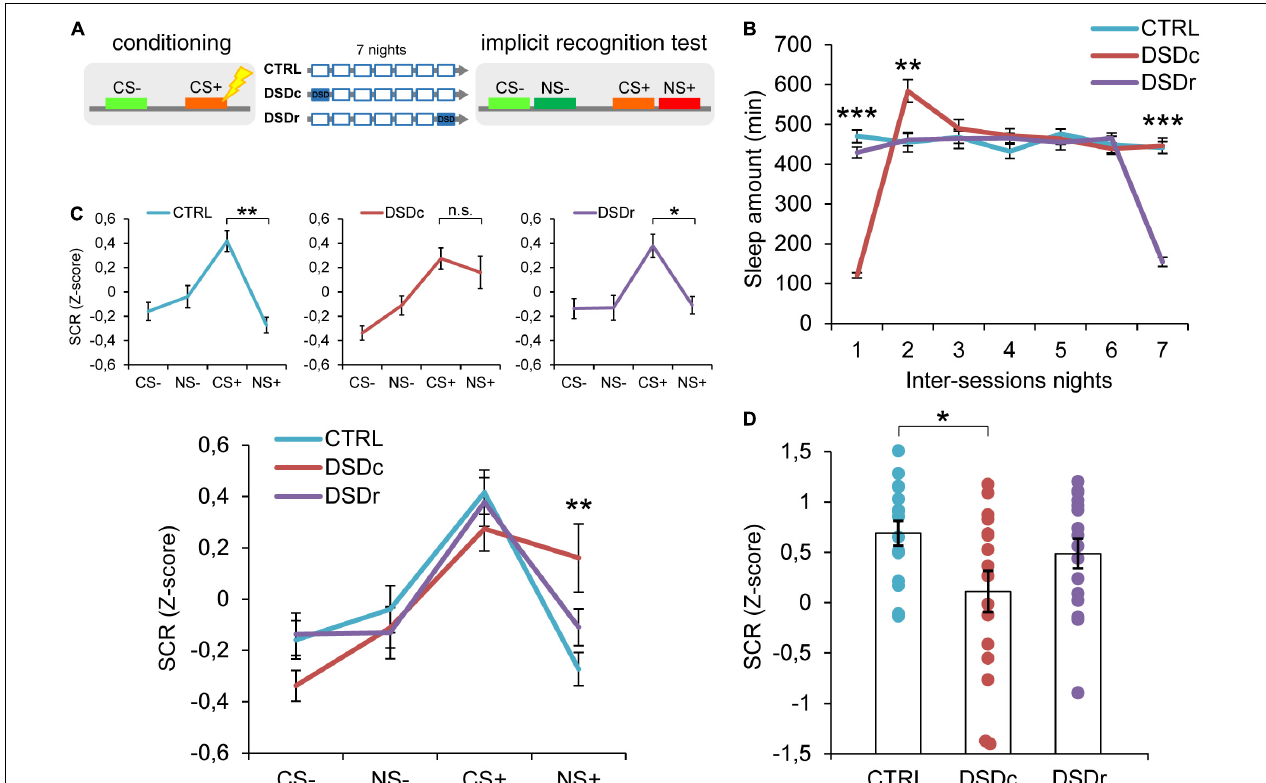
FIGURE 1 | Effects of DSD on implicit threat memories, safety memories, and threat generalization to new stimuli. (A) Schematic diagram depicting the experimental design. Participants underwent a differential threat conditioning in which a conditioned tone (CS+) was paired with a mild electrical shock (US) and a non-reinforced tone (CS–) was never paired with the US. One group of participants (CTRL, n = 16) was allowed to regularly sleep during the seven nights between the sessions. The other two groups were sleep-deprived during the night after the first session (DSDc, n = 16) or during the night before the second session (DSDr, n = 16). One week after the conditioning session, subjects underwent an implicit 2AFC recognition task during which they were presented with tone pairs composed of a conditioned stimulus (CS– or CS+) and a new stimulus similar to the CS– (NS–) or the CS+ (NS+), while SCRs were recorded. (B) Actigraphically controlled sleep distributions of each group over the seven nights separating the experimental sessions. (C) Implicit reactions to the learned threatening (CS+) and safety-signaling (CS–) stimuli were comparable among conditions, whereas implicit reactions to the new stimulus (NS+) were higher in the DSDc group than in the CTRL group. Implicit reactions to the NS+ were weaker than those to the CS+ in the CTRL and the DSDr but were similar to those to the CS+ in the DSDc group. (D) Specificity of defensive responses (CS+ minus NS+) was higher in the CTRL group than in the DSDc group. * P < 0.05, ** P < 0.01, *** P < 0.001. All data are mean and SEM. 3 × 7 mixed ANOVA followed by Bonferroni corrected simple main effect analyses (B) ; 3 × 4 mixed ANOVA followed by Bonferroni corrected simple main effect analyses (C) ; One-way ANOVA followed by Bonferroni-adjusted post hoc comparisons (D)